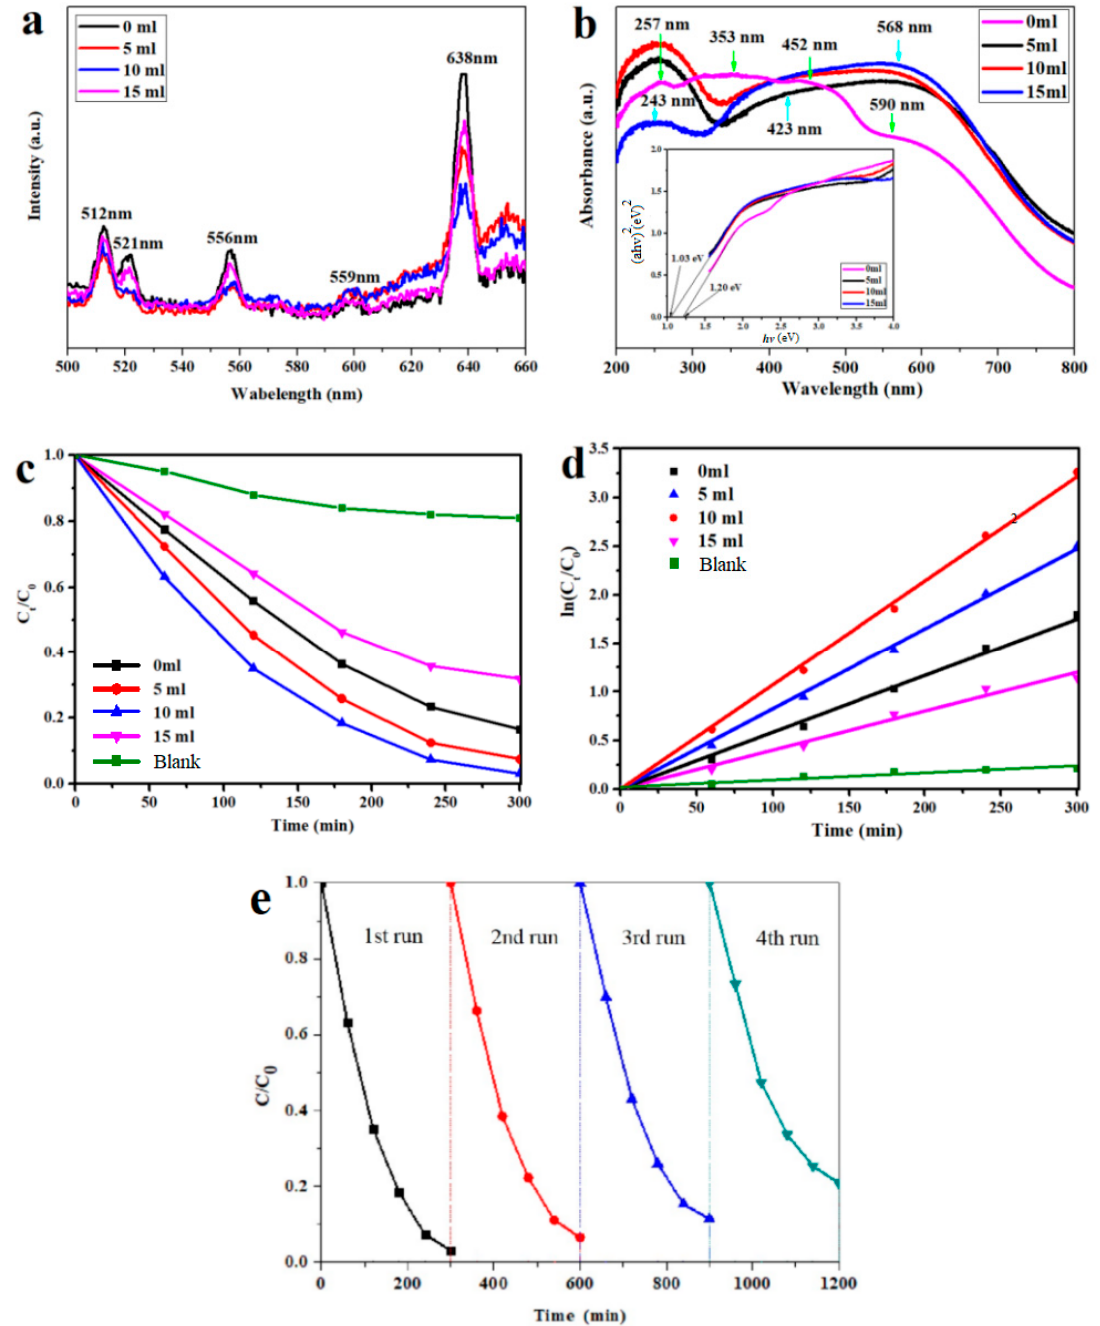
Figure 4. PL spectra ( a ), UV-vis absorption spectra ( b ), efficiency ( c ) and pseudo-first-order ( d ) of MB degradation using different CeVO 4 -V 2 O 3 samples under visible-light radiation. Cycling runs of MB photodegradation over CeVO 4 -V 2 O 3 samples with 10 mL EG ( e ).